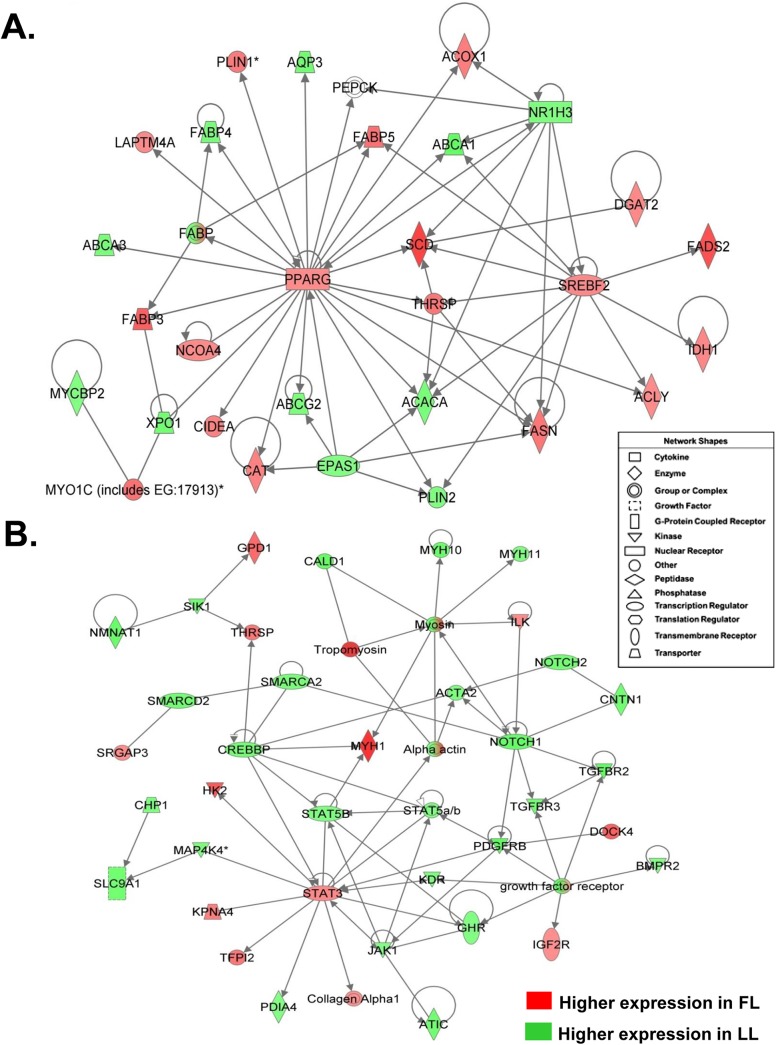
Gene interaction networks of highest-expressed (HE) genes in abdominal fat of chickens associated with lipogenesis and adipogenesis.Functional gene interaction networks were identified by Ingenuity Pathway Analysis (IPA). Genes are colored based on fold-change values determined by RNA-Seq analysis, where the red-color symbols signify higher expression in FL chickens and green-color gene symbols indicate higher expression in LL chickens. The false discovery rate (FDR) and fold-difference cutoff were not used in this functional analysis of the highest-expressed (HE) genes, which is simply based on a high number of reads mapped to known transcripts. Each gene was assigned a shape and function by IPA as shown in the “Network Shapes” legend inset. The direct gene interaction network in the top panel (A) was functionally annotated by IPA as “Lipid Metabolism, Molecular Transport, and Small Molecular Biochemistry”, which emphasizes transcriptional regulation of adipogenesis and lipogenesis. The direct gene interaction network in panel (B) was functionally annotated by IPA as related to “Cellular Development, Cellular Growth and Proliferation, and Cellular Movement”.